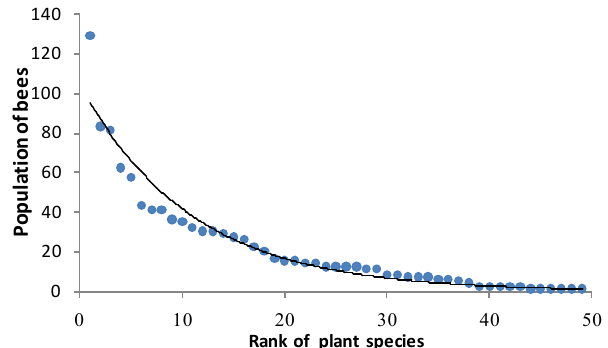
sativum and H. annuus (Table 1).